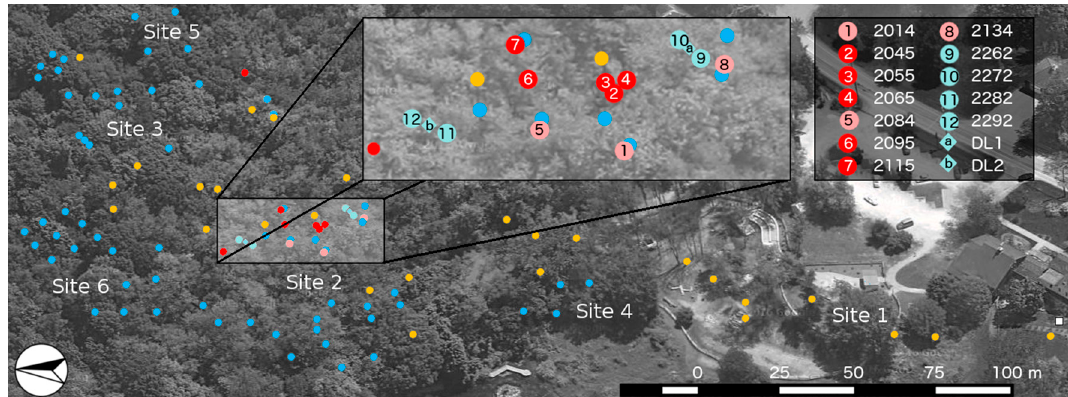
Figure 5. Map of the six sites of the ASWP testbed (October 2016 configuration). Relay nodes are represented as yellow circles, sap flow nodes are represented as red circles (the three pink circles in site 2 are used in this analysis), soil sensor nodes are represented as dark blue circles, and the base station is represented as a white square. The data loggers used for validation (i.e., DL1 and DL2) are shown as light blue diamonds and their corresponding nodes as light blue circles. The four-digit node numbers referenced in the analysis are indicated in the zoomed region of site 2.